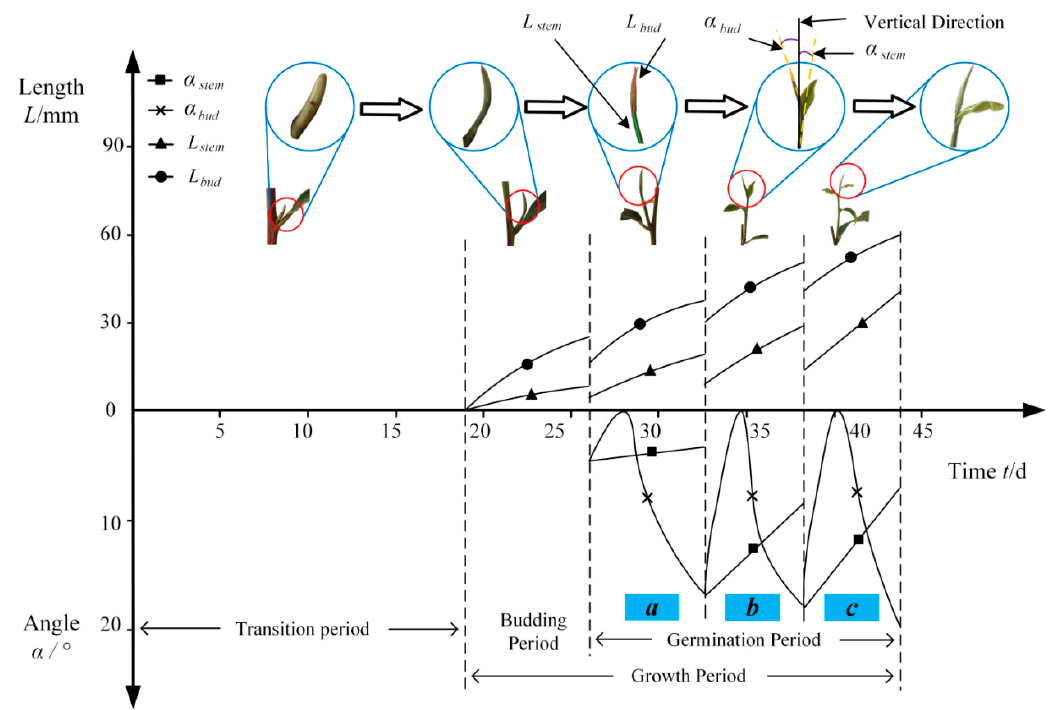
Figure 9. Growth cycle diagram of Yinghong #9 tea. Note: a, b, and c represent the stage of one shoot with one leaf, one shoot with two leaves, and one shoot with three leaves, respectively.